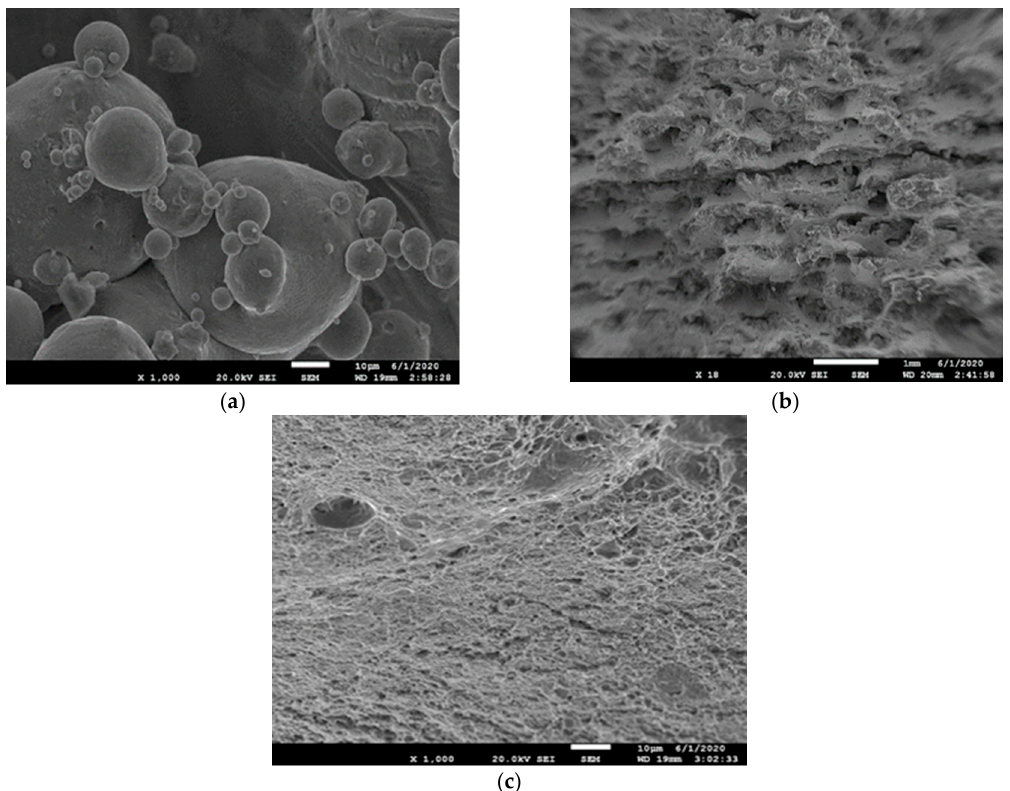
Figure 11. The fractured surface of the hexagonal family 3 (samples 25–27) with ( a ) unmelted particles, ( b ) step-like features with propagation along the fusion zones between each build layer, and ( c ) dimple like features in the region between fusion zones. Metals 2021 , 11 , x FOR PEER REVIEW